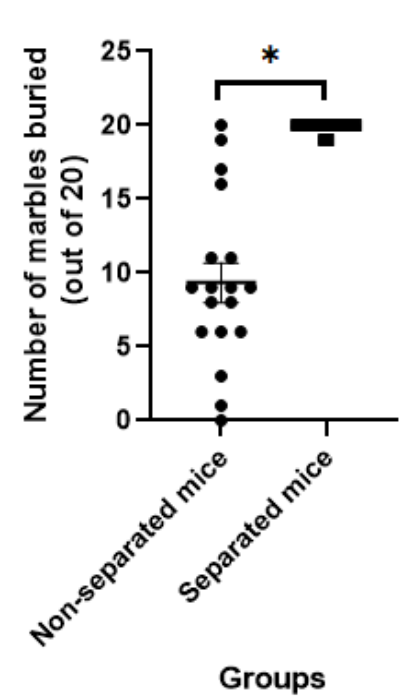
Figure 6. ( a ) Number of marbles buried at 15 min during MB test. ( b ) Number of marbles buried at 30 min during MB test. (*) indicates significant difference ( p < 0.05) between separated and non- separated mice by the unpaired t test ( n = 18/each group).